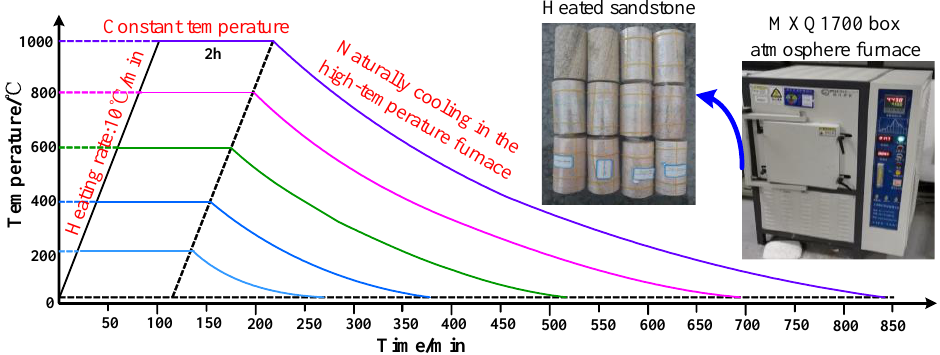
Figure 2. Heating curves of sandstone samples [30].